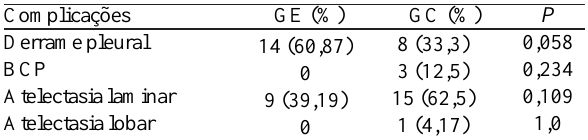
Tabela 4. Complicações respiratórias no pós-operatório.